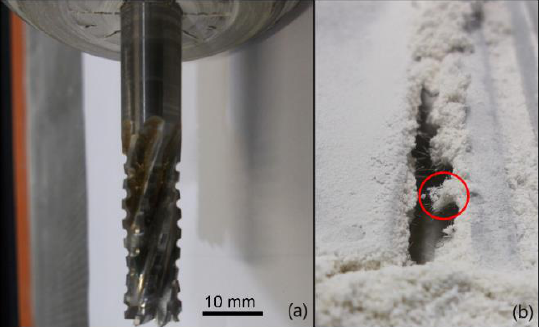
Figure 4. Sobelcomp setup: ( a ) Experimental setup with the T2 cutting tool; ( b ) Closeup on a workpiece (example of delamination under the composite dust highlighted).